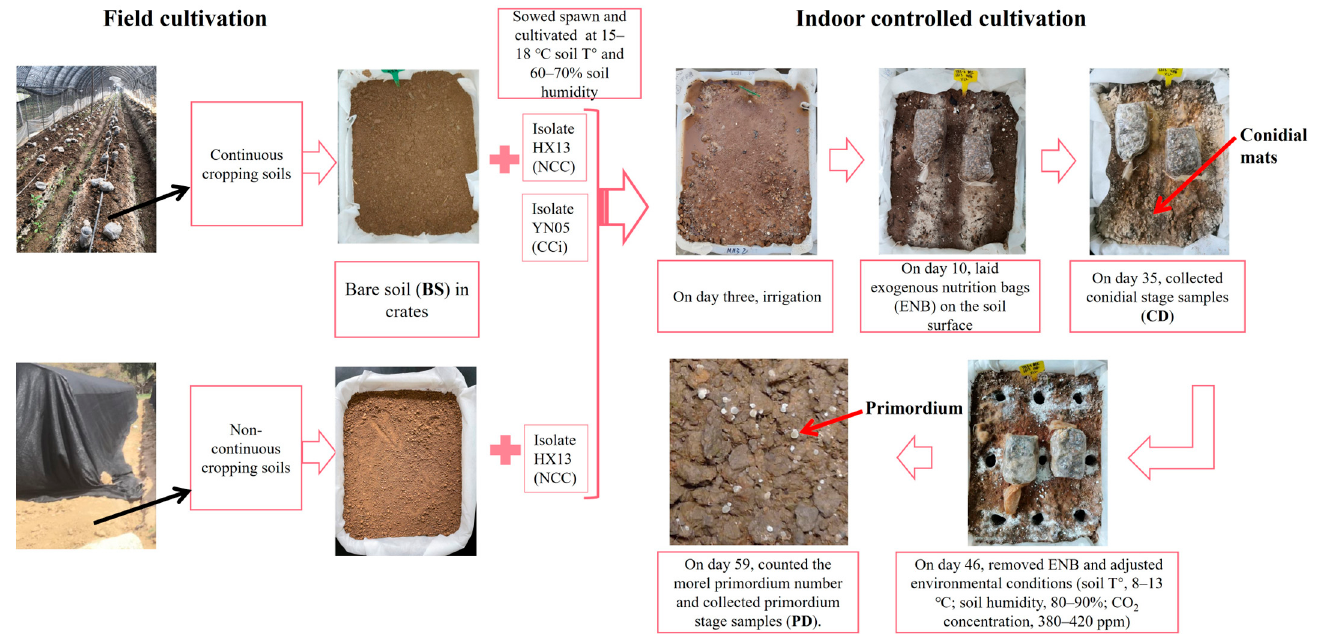
Figure 1. Schematic diagram of the experimental design.